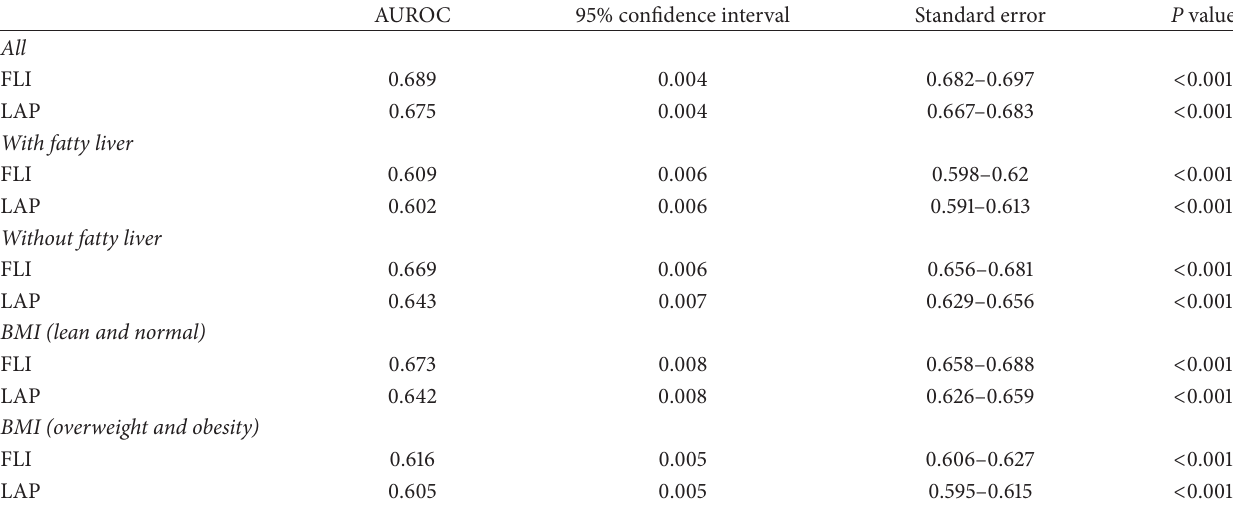
Table 5: Comparison of AUROC curve values among noninvasive markers for predicting